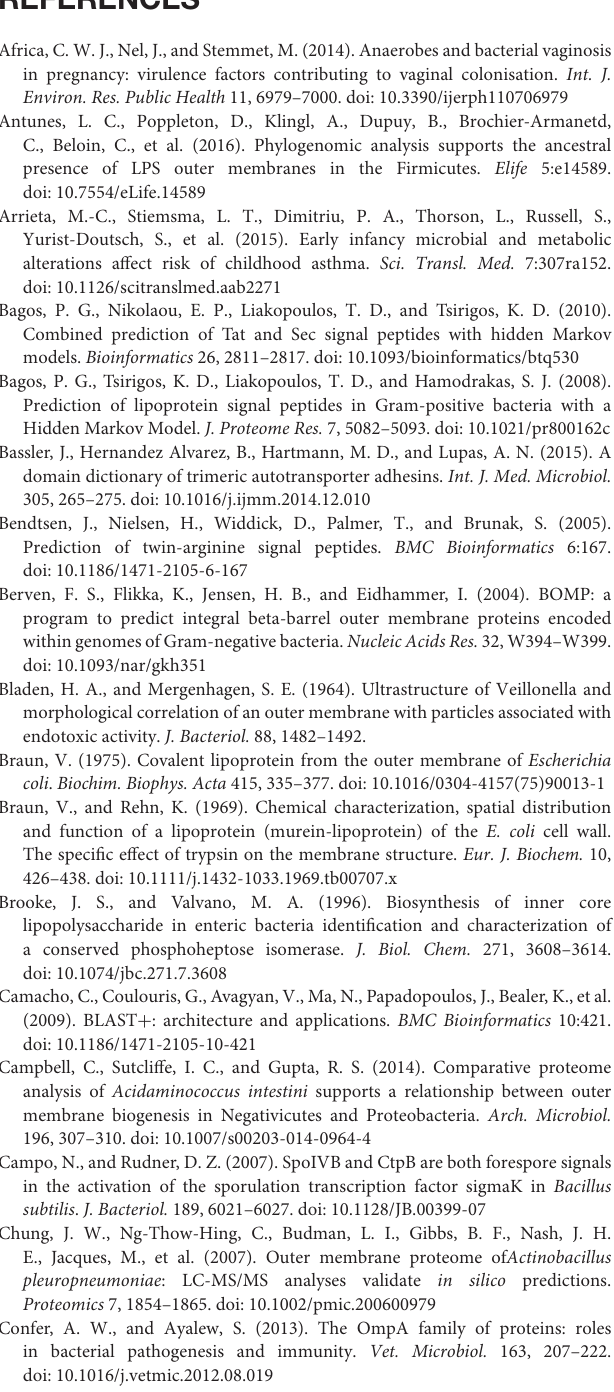
Table S4 | Type 4 pili components in silico digestion and detection.